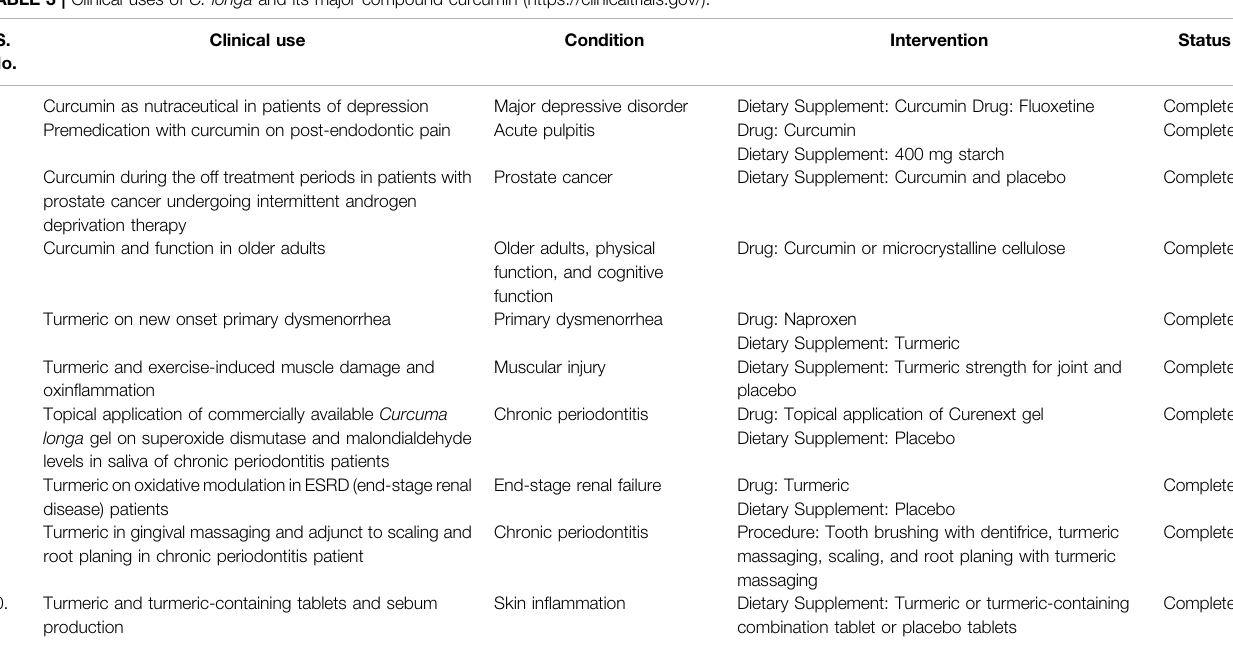
TABLE 3 | Clinical uses of C. longa and its major compound curcumin (https://clinicaltrials.gov/). S.